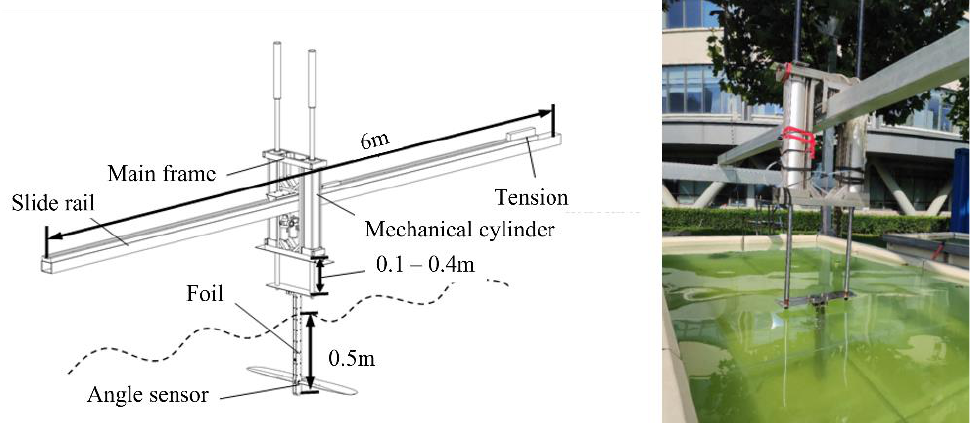
Figure 10. The experimental device.